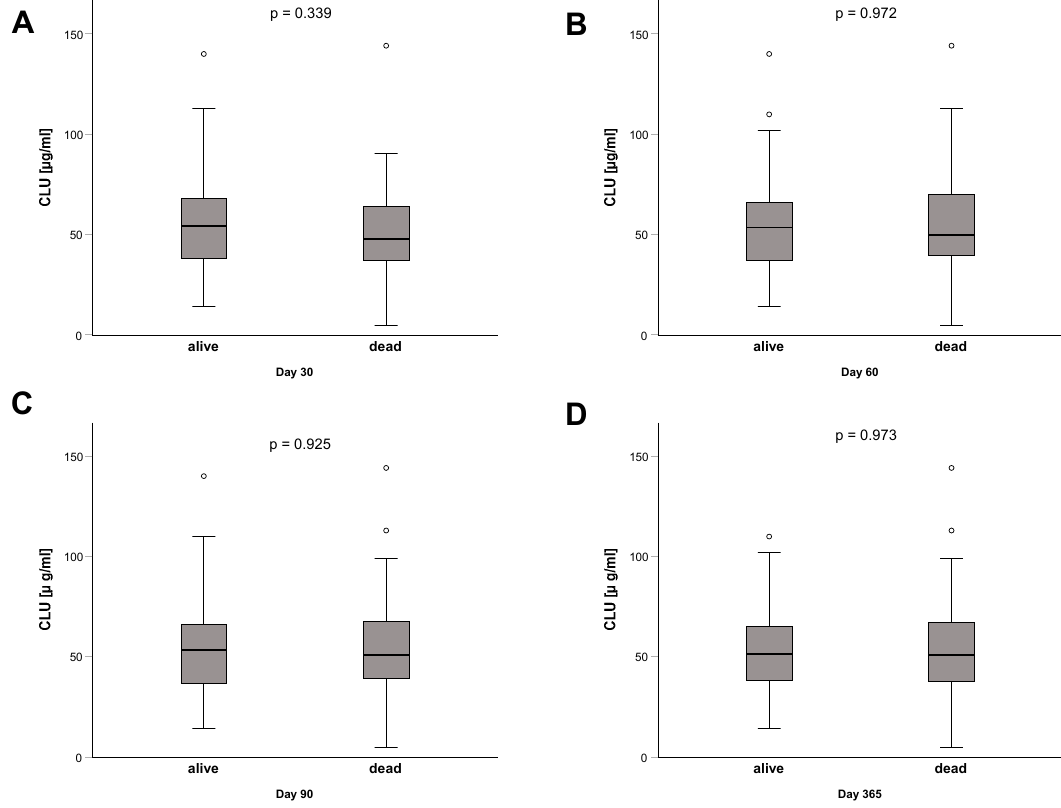
Figure 5. Clusterin is not a prognostic biomarker for mortality in critically ill patients. Clusterin plasma concentrations did not differ between survivors and non-survivors 30 days after ICU admission ( A ), 60 days after admission ( B ), 90 days after admission ( C ), or one year after admission ( D ), respectively. p -values (U-test) are given in the figure. ICU, intensive care unit. Circle depicts outlier.